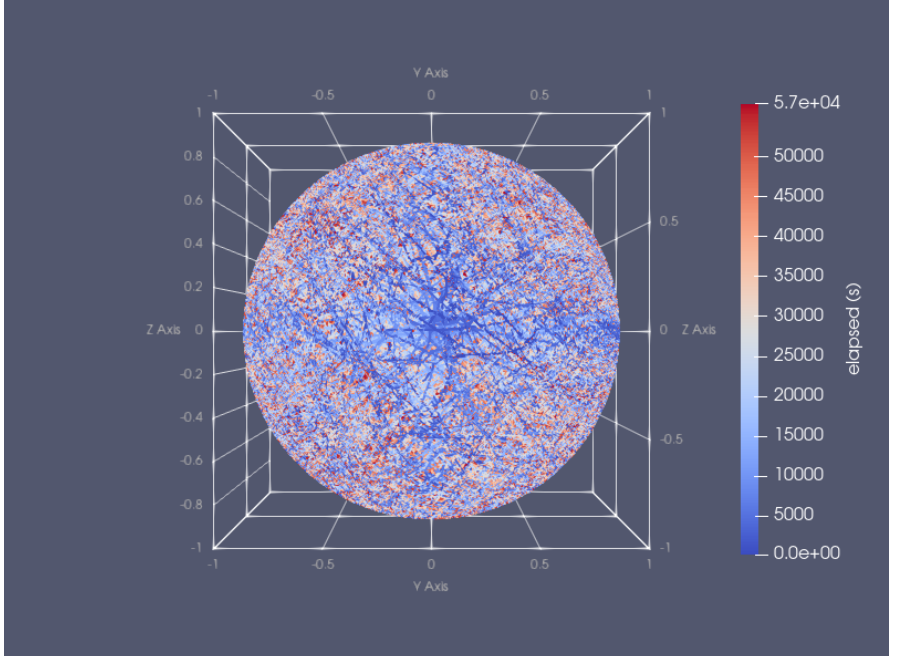
Figure A5. Motion trajectory of the gravity vector tip in random mode ( ω φ and ω ϕ are randomly selected from range of 0.0524 [rads/s] to 0.733 [rads/s] and periods of rotation of both frames are randomly selected from 1 to 10 periods) for time of 15